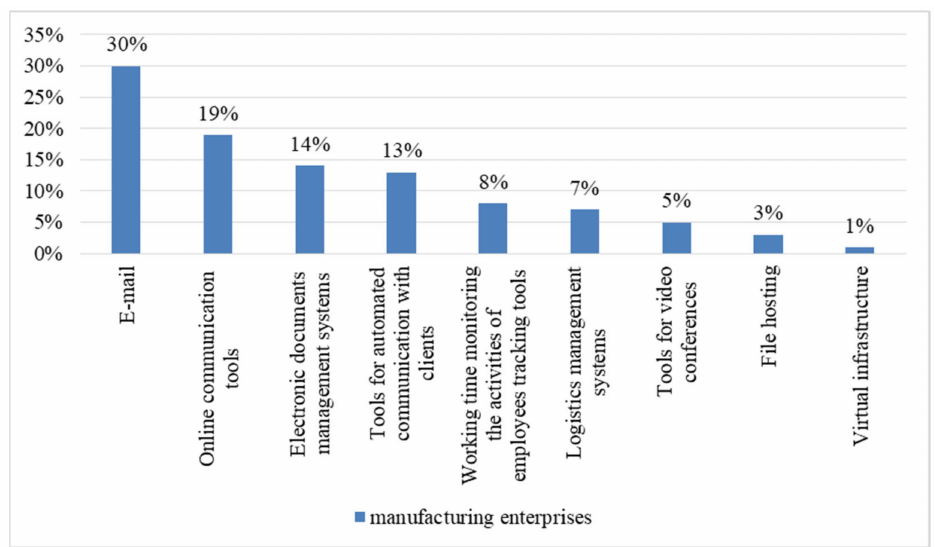
Figure 2. ICT—tools used in production enterprises the Republic of Mordovia.